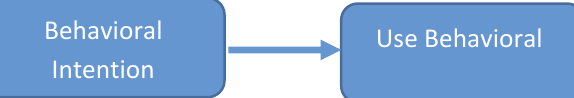
Fig. 5. Relations Behavioral Intention and Use Behavior Source (Tarhini et al., 2016)